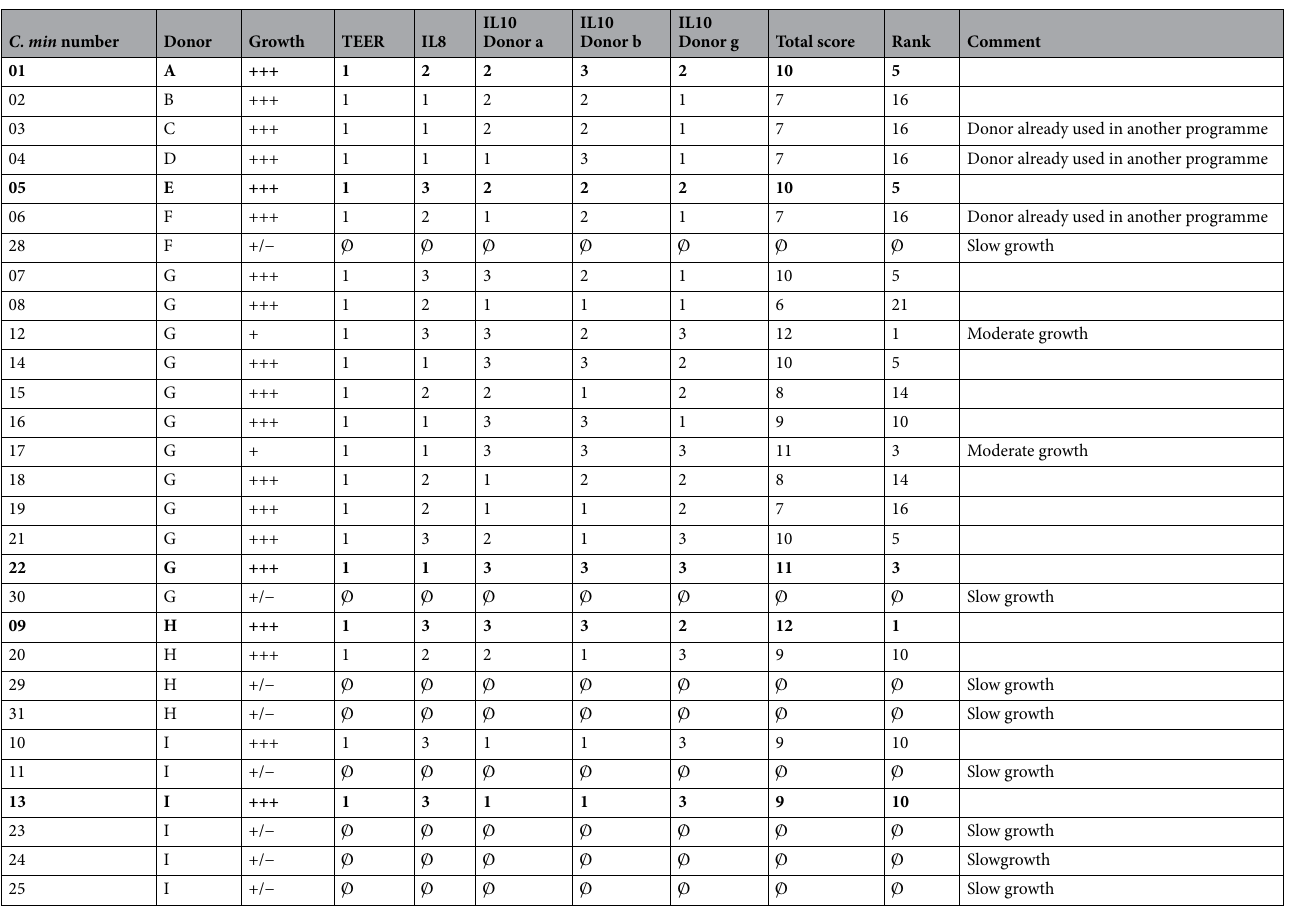
Table 1. Summary of the initial C. minuta collection and screening results. Pre-selected strains after STEP 1 are shown in bold. / O indicates that the strain was not included in the